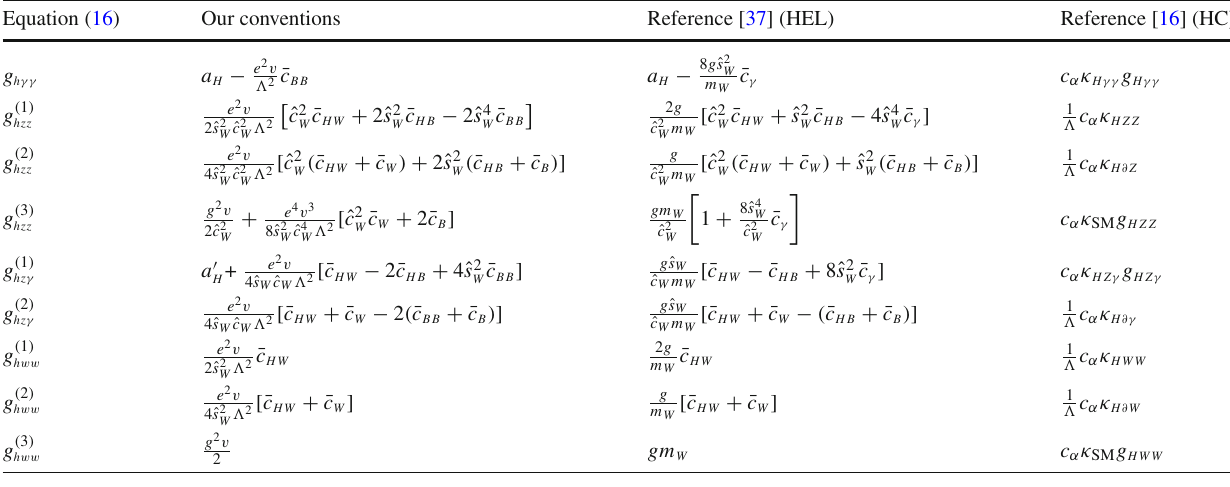
have been explicitly indicated H